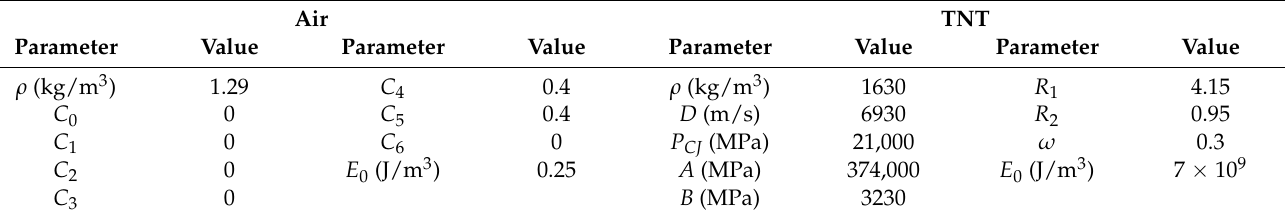
Table 7. Key parameters of air and TNT